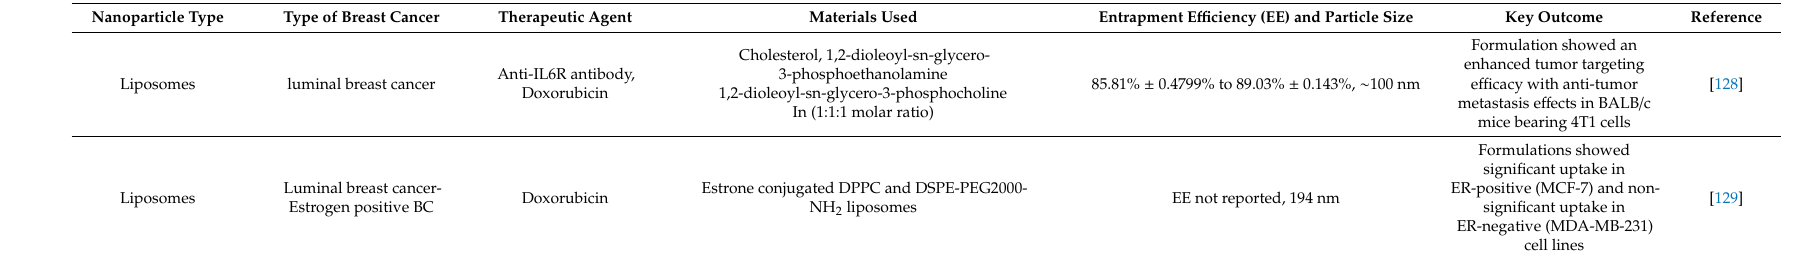
Table 7. List of some nanomedicines explored for the treatment of breast